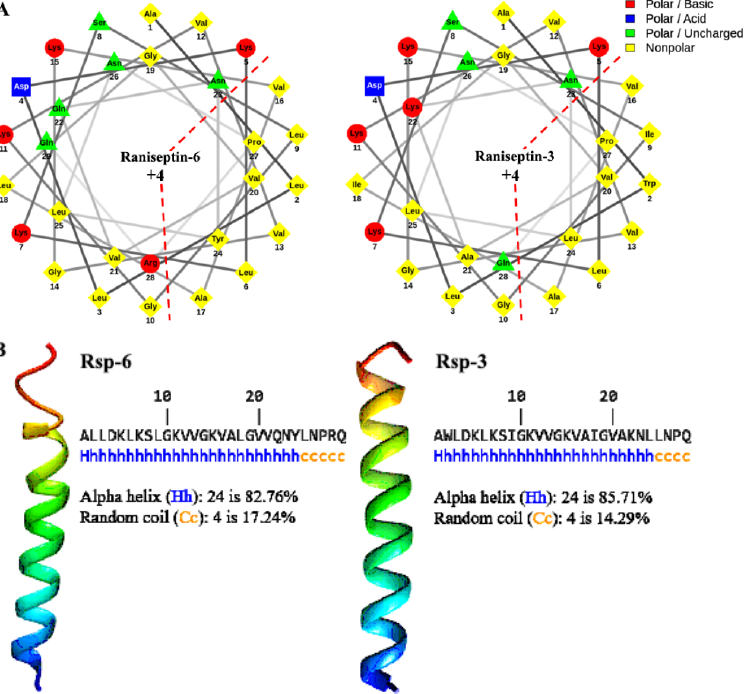
Figure 5. ( A ). Schiffer–Edmundson helical projections made using NetWheels of the antimicrobial peptides Raniseptins-3 and -6, highlighting the hydrophobic face of both peptides. ( B ). Secondary structure models for Raniseptins-3 and -6 using the I-TASSER server. In blue, the most electronega- tive region (N-terminal) can be observed, and in red, the electropositive region (C-terminal) can be observed.